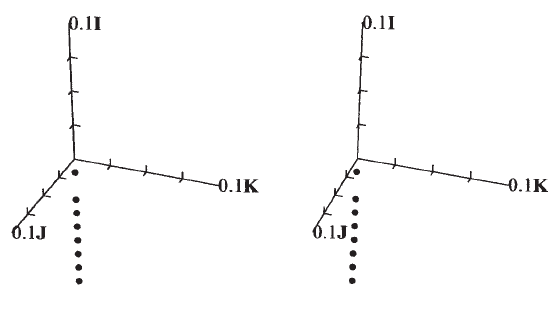
Figure 1b. Scatter plot of 50 measurements of refractive state of a test eye. Operator refocused the instrument after each measurement and the instrument triggered itself when ade- quately focused. Length of axes: 0.1 D. For details see